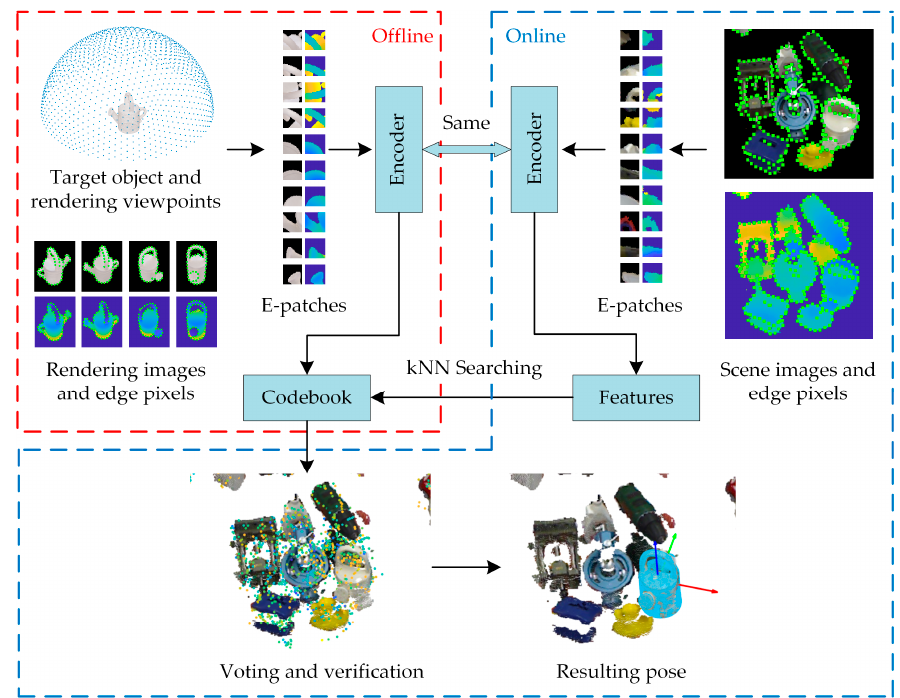
Figure 6. Framework of the E-patch-based method for object detection and pose estimation (ODPE) Figure6. tasks.